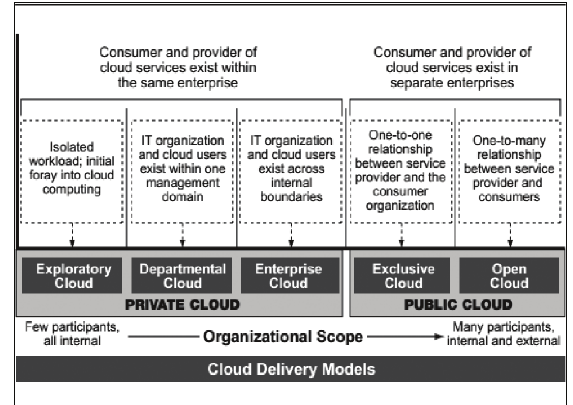
Fig.2. Roles and responsibilities (source: 18,19).